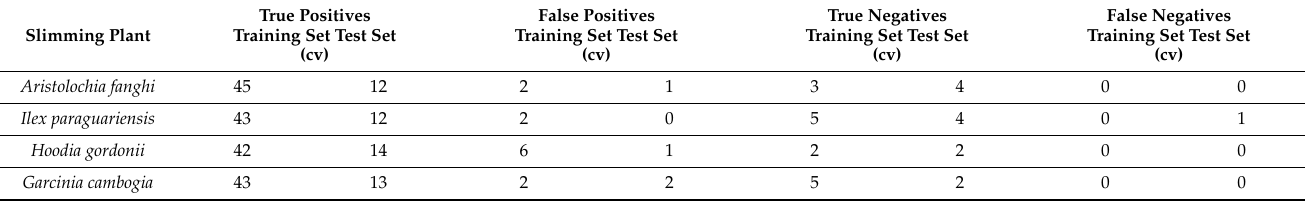
Table 4. The overall depiction of the confusion matrix summarizing best predicting binary models for the 4 plants. The training set consists of 50 samples and the test set consists of 17